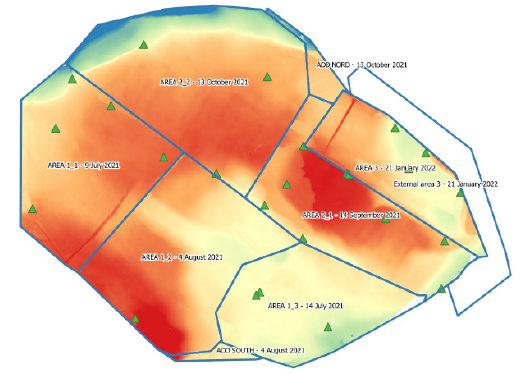
Figure 8 . TLS subareas surveyed before vegetation removal stages